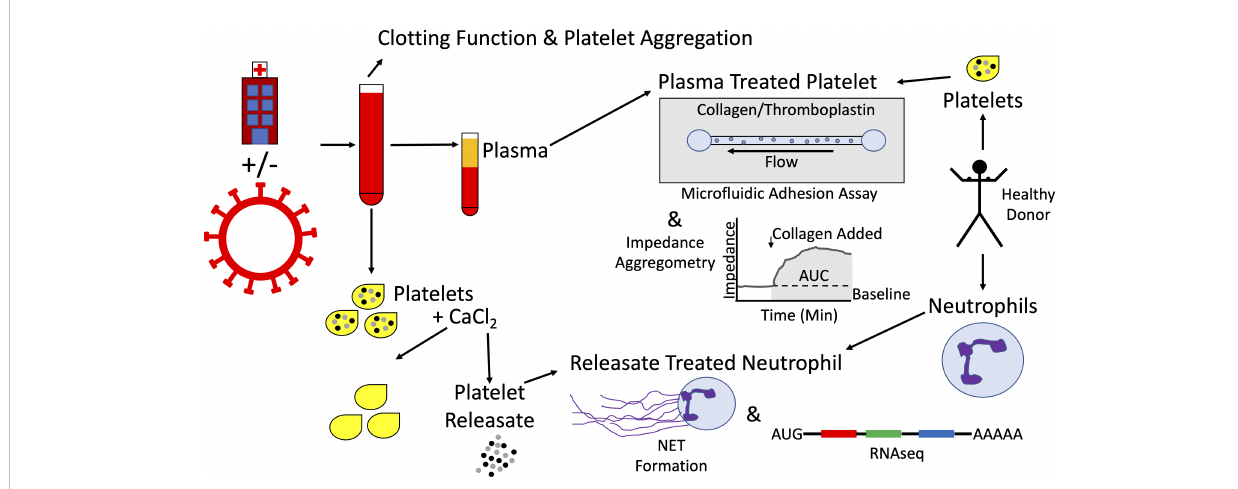
FIGURE 1 Schematic representation of experimental strategy. Patients being evaluated for COVID-19 were enrolled on arrival to the emergency department, yielding tandem cohorts of COVID-19 patients and symptom-matched disease control patients. Whole blood was collected and clotting function and platelet aggregation were assessed by thromboelastography and multiple electrode impedance aggregometry, respectively. Whole blood was processed into plasma and stored at -80°C. Platelets were isolated, exposed to calcium chloride, and the resulting platelet releasate was collected and stored at -80°C. Separately, platelets were isolated from healthy donors, exposed to plasma samples, and their adhesion and aggregation properties were studied using a micro fl uidic parallel plate fl ow chamber and multiple electrode impedance aggregometry, respectively. Neutrophils were isolated from healthy donors and exposed to platelet releasates from COVID-19 patients and disease controls. Neutrophil extracellular trap (NET) formation was assayed and neutrophil RNA was